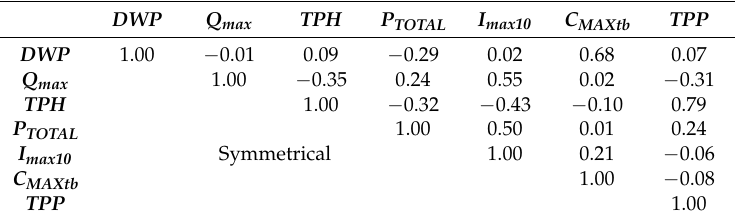
Table 7. Correlation matrix for variables of rainfall events at S1 Catchment. DWP Q max TPH P TOTAL DWP